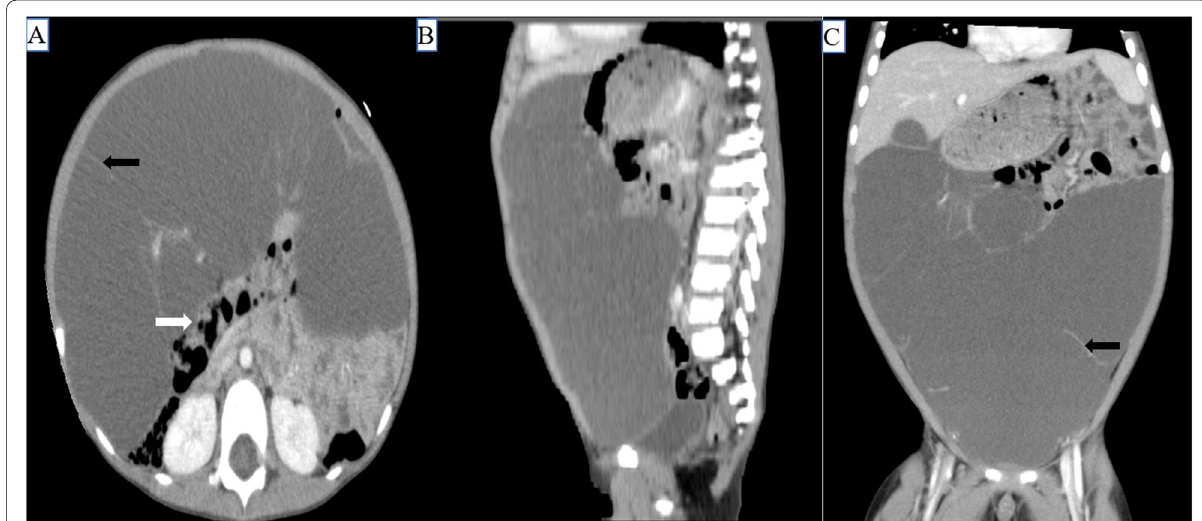
Fig. 2 Axial ( A ), sagittal ( B ), and coronal ( C ) images of contrasted CT abdomen and pelvis demonstrates a huge intraperitoneal fluid collection with internal septations (black arrow), located anteriorly and causing mass effect and posterior displacement of the bowel loops (white arrow) and kidneys indicating a space-occupying intraabdominal cystic lesion arising from the omentum